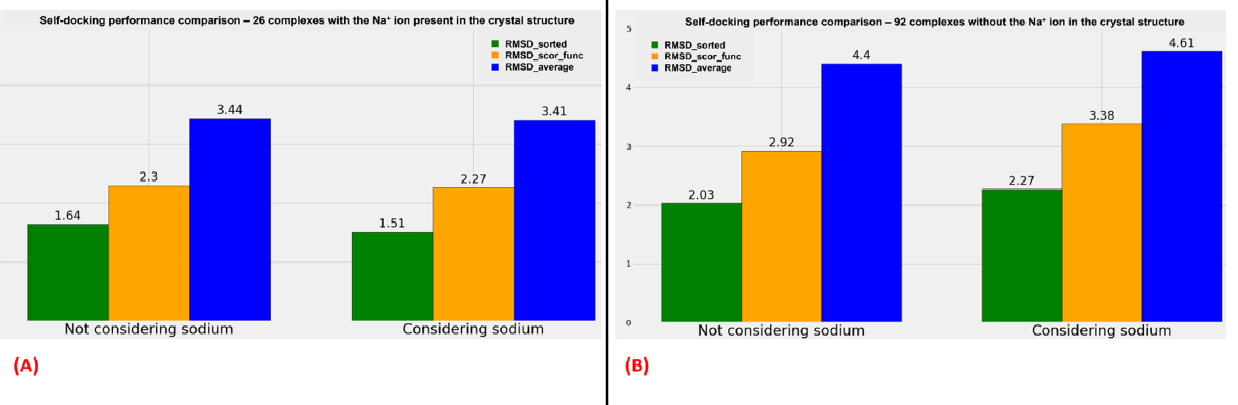
3.46%, the reduction in “RMSD_scor_func” is 11.47% (this higher value has to be